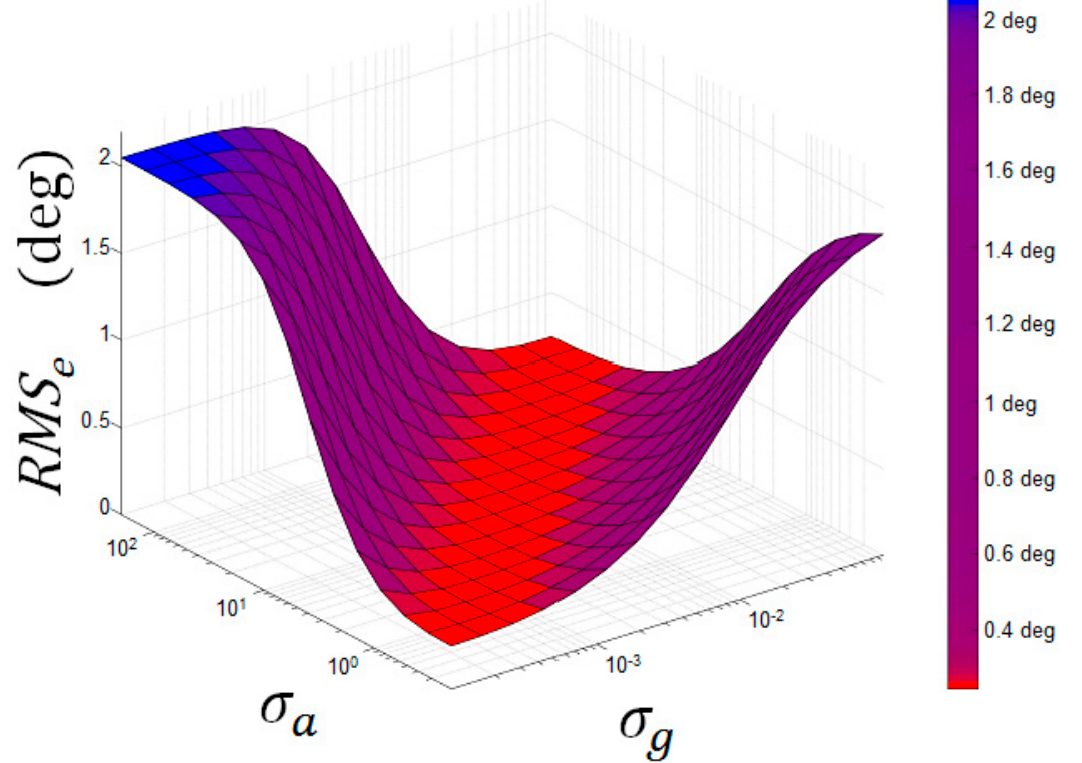
Figure A2. RMSe between the orientation estimated with the optoelectronic system and the Kalman filter depending on the values of Kalman parameters σ g and σ a for the slow intensity